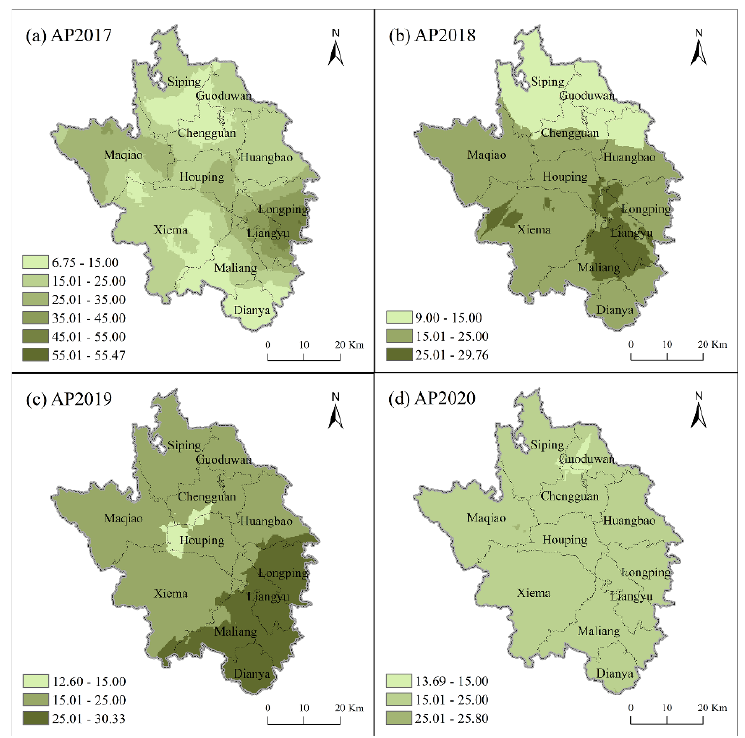
Figure 6. Ordinary kriging distribution maps for ( a ) 2017 AP, ( b ) 2018 AP, ( c ) 2019 AP and ( d ) 2020 AP.